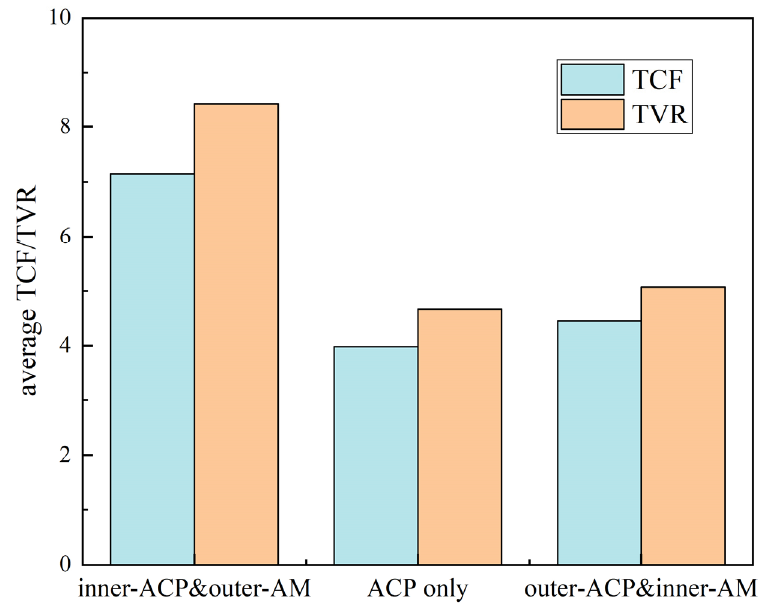
Figure 7. The TCF and TVR with different insulation